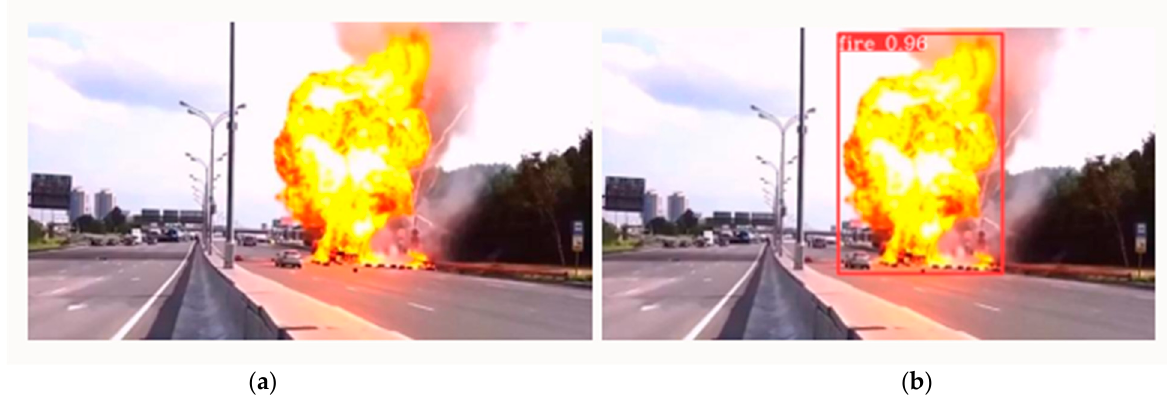
Figure 7. Fire scenarios included experiments: ( a ) input image and ( b ) output image with fire detected region.